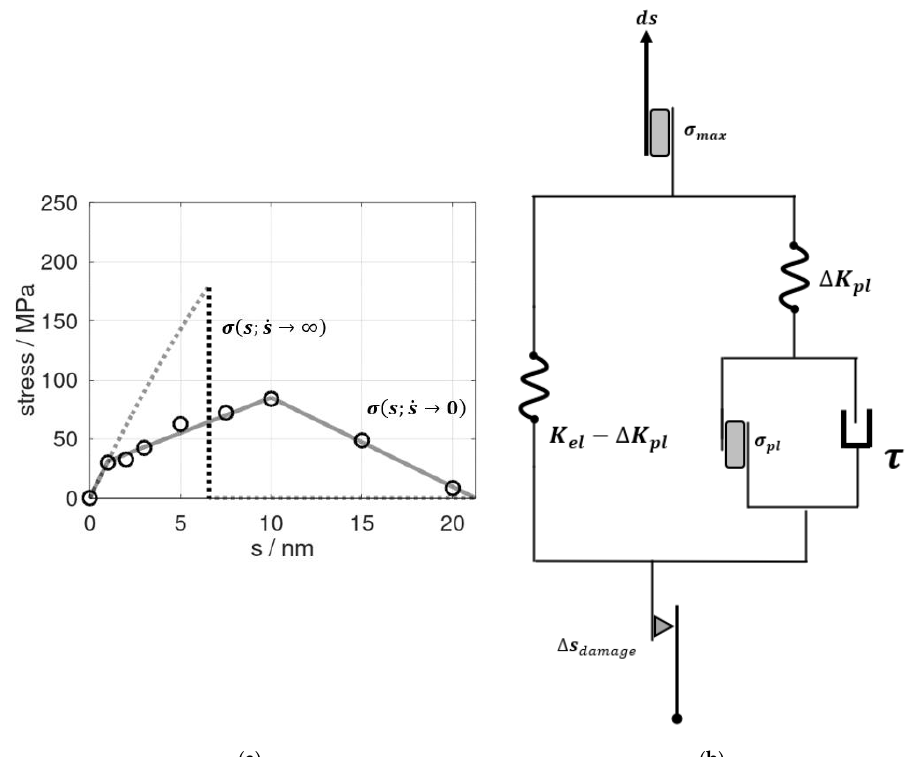
Figure 1. ( a ) Stress profiles as functions of the elongation s of the epoxy model. The dots refer to data from molecular dynamic simulations combined with extrapolation analyses for 𝑡 → ∞ of stress relaxation at constant s as adopted from [13]. On this basis, 𝜎(𝑠; 𝑠̇ → 0) was mimicked by a tri-linear profile discriminating the elastic/visco-elastic regime (up to s = 1 nm), plastic deformation (1 nm < s ≤ s crit = 10 nm), and cavitation/fracture (10 nm < s ≤ s sep = 21.2 nm), as shown by the solid lines. In turn, the stress induced by rapid pulling (dashed curve) was modelled by an effective elastic profile for which the spring constant reflected Young ’ s modulus up to s = 1 nm. At a maximum stress of 𝜎 𝑚𝑎𝑥 (𝑠 = 6.5 nm ; 𝑠̇ = 1 𝑣 𝑠𝑜𝑢𝑛𝑑 ) = 185 MPa, an abrupt failure was implemented according to molecular dynamic simulations performed at a pulling rate of 840 m · s − 1 (~50% of the speed of sound in the bulk resin). ( b ) Concept of an elastoplastic model to mimic the change of stress d σ in response to increments of the elongation d s . At the vanishing strain rate σ , a parallel setup